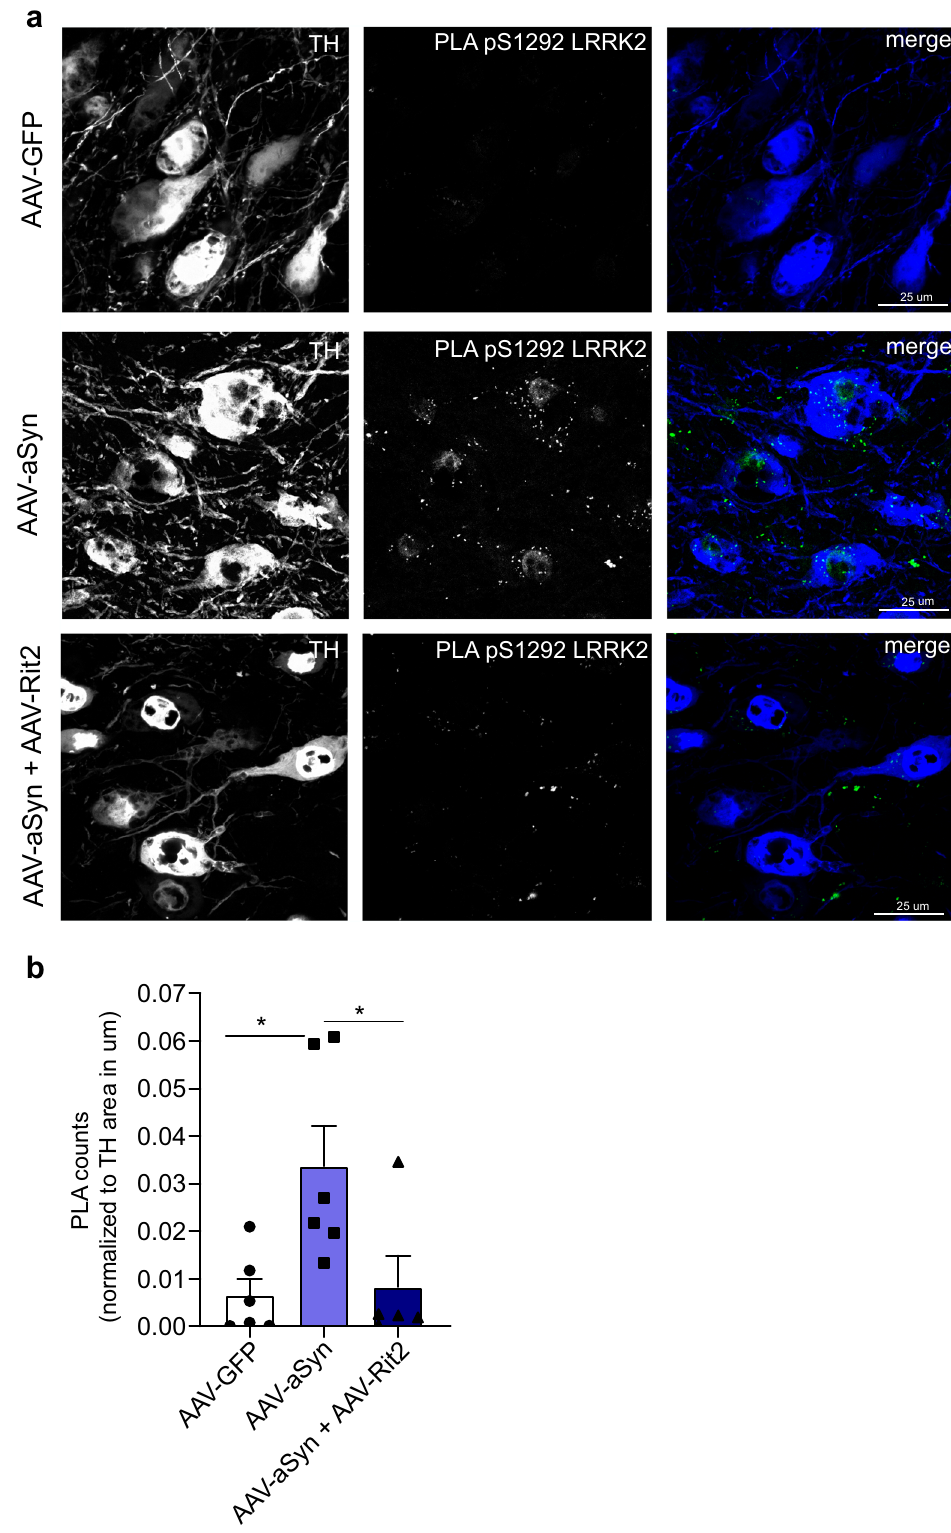
Fig. 7 In vivo aSyn overexpression increases endogenous LRRK2 activity, which is prevented by Rit2 co-expression. a PLA analysis of AAV- GFP, AAV-A53T-aSyn and AAV-A53T-aSyn + AAV-Rit2 injected mice in TH-positive neurons in the SNc. b Quanti fi cation of PLA counts in TH- positive neurons shows a signi fi cant increase of endogenous LRRK2 kinase activity with AAV-A53T-aSyn injection. The increase is completely prevented by co-injection of AAV-Rit2 with AAV-A53T-aSyn (AAV-GFP = 6 animals, AAV-A53T-aSyn = 6 animals, AAV-A53T-aSyn + AAV-Rit2 = 5 animals). Data represented as mean ± SEM. * p < 0.05, one-way ANOVA followed by Bonferroni ’ s post hoc